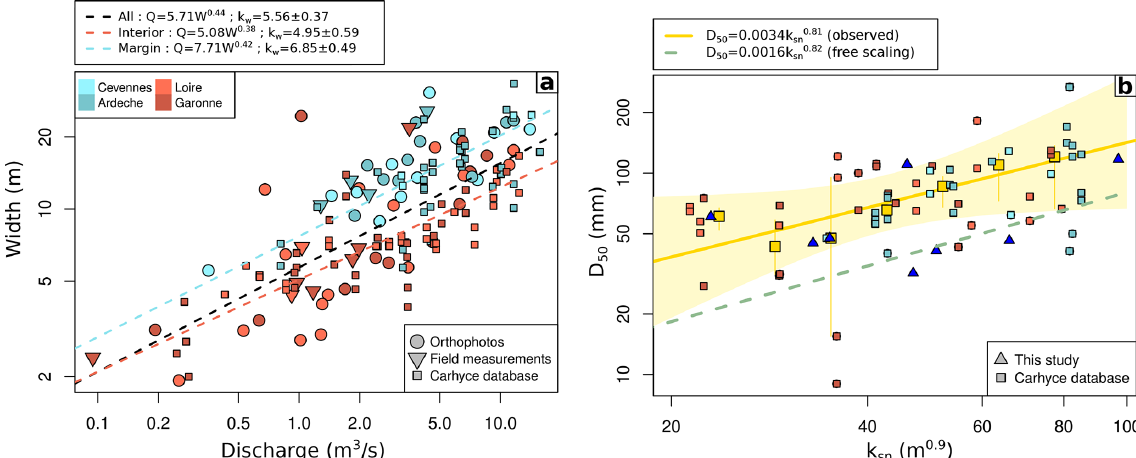
Figure 5. (a) Bankfull river width against discharge calculated using the calibration in Fig. 4. Circles, triangles, and squares correspond to orthophotos measurements, field measurements, and data from the Carhyce database (Gob et al., 2014), respectively. The dashed black line is a power-law fit of the whole dataset, whereas blue and red dashed lines correspond to fits to the Ardèche–Cévennes (high relief, east of the divide) and Loire–Garonne (lower relief, west of the divide) subregions, respectively. Symbols are colored according to the four different subregions. (b) Median bedload size D 50 as a function of steepness index k sn . Triangles and squares correspond to our field measurements and the Carhyce database, respectively. Yellow squares are binned values (median and interquartile range), and the yellow line is the corresponding power-law fit (Eq. 13), with its 99% confidence envelope. The dashed green line corresponds to the estimate of the parameters in Eq. (13) from the model presented in Fig.